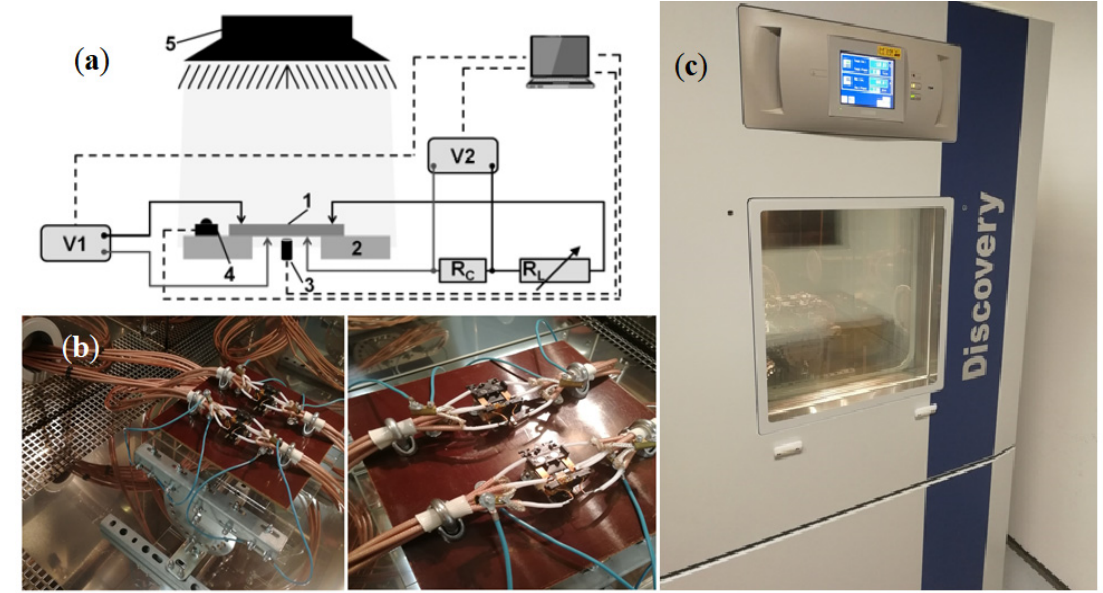
Figure 19. Silicon samples laboratory stand. ( a ) Schematic diagram of the laboratory stand: 1—solar cell, 2—supporting construction, 3—temperature sensor, 4—pyranometer, 5—light source, V1—Fluke 289, V2—The LCR-8110G Series LCR meter, RC—shunt resistor, RL—adjustable load. ( b ) Special measuring holders inside the climate chamber to hold silicon samples. ( c ) Discovery DY600C climate chamber [90].